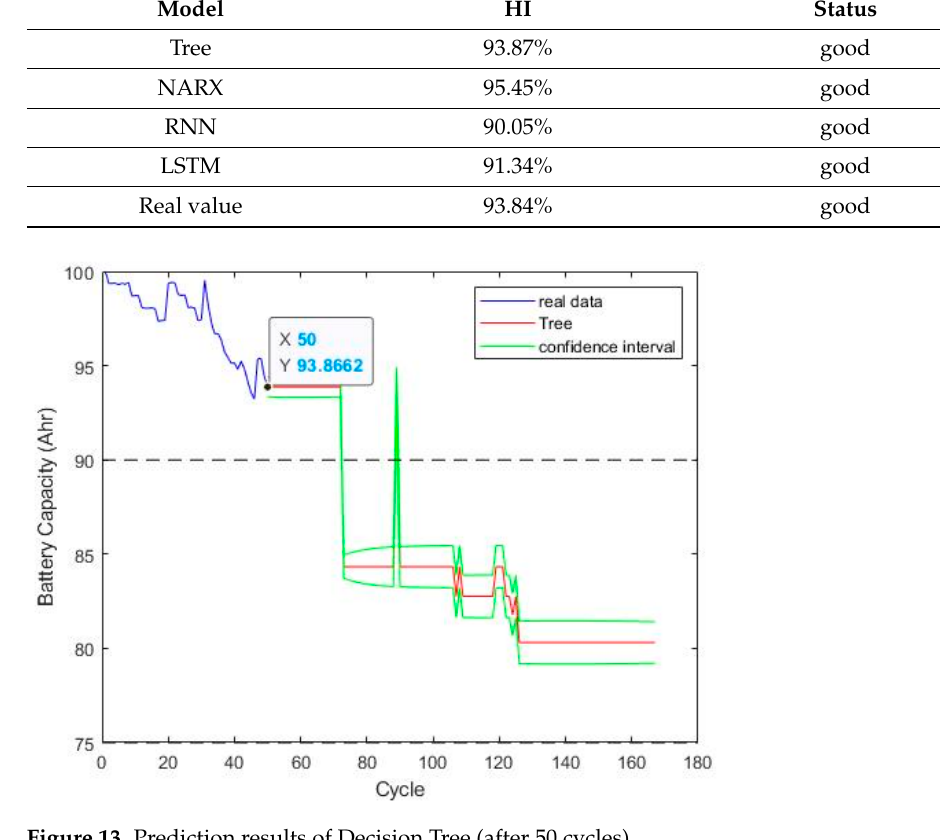
Figure 15. Prediction results of RNN (after 50 cycles).